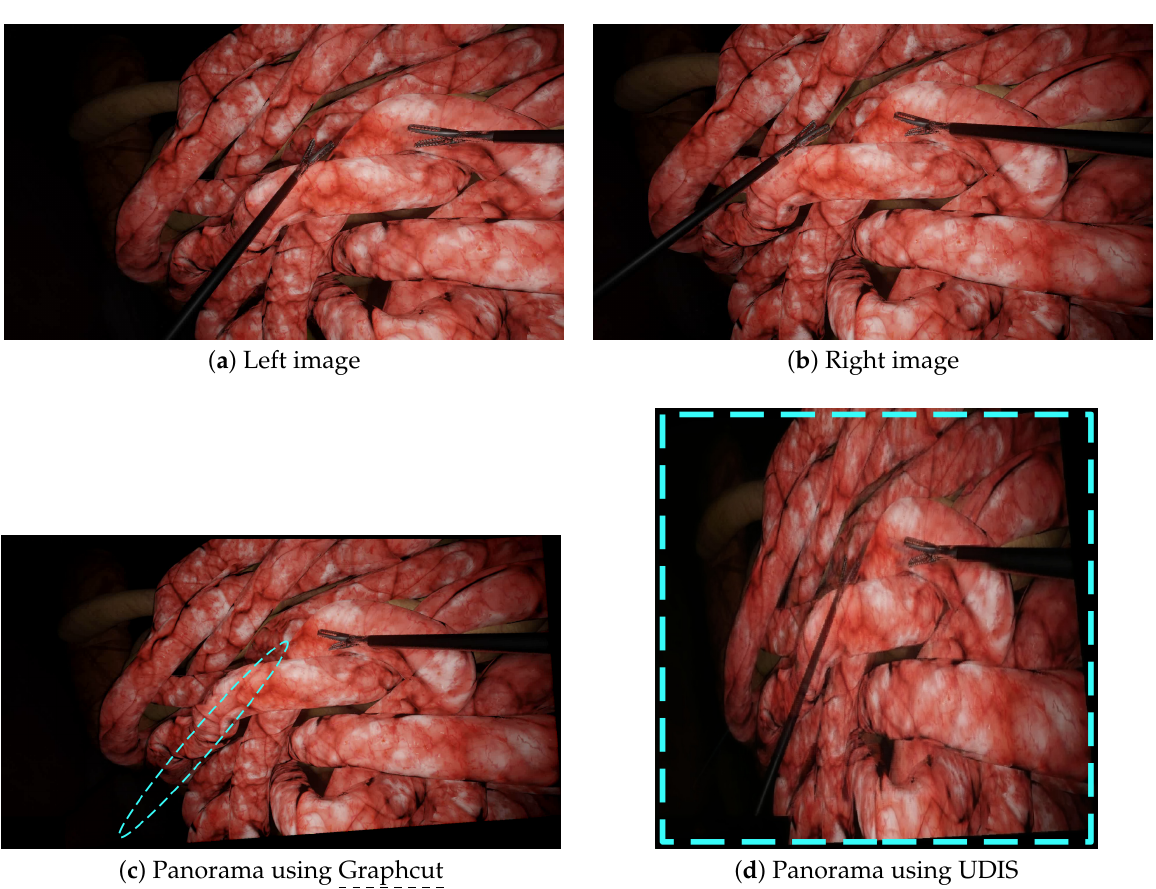
Figure 6. A scenario with more parallax: the left ( a ) and right ( b ) images were stitched together by Graphcut and UDIS. ( c ) With Graphcut, only one tool was present in the final panorama while there were two tools in the input images. ( d ) With UDIS, the two tools appeared in the resulting panorama but with huge projective distortions. The blue dashed lines show the major issues (missing tools and